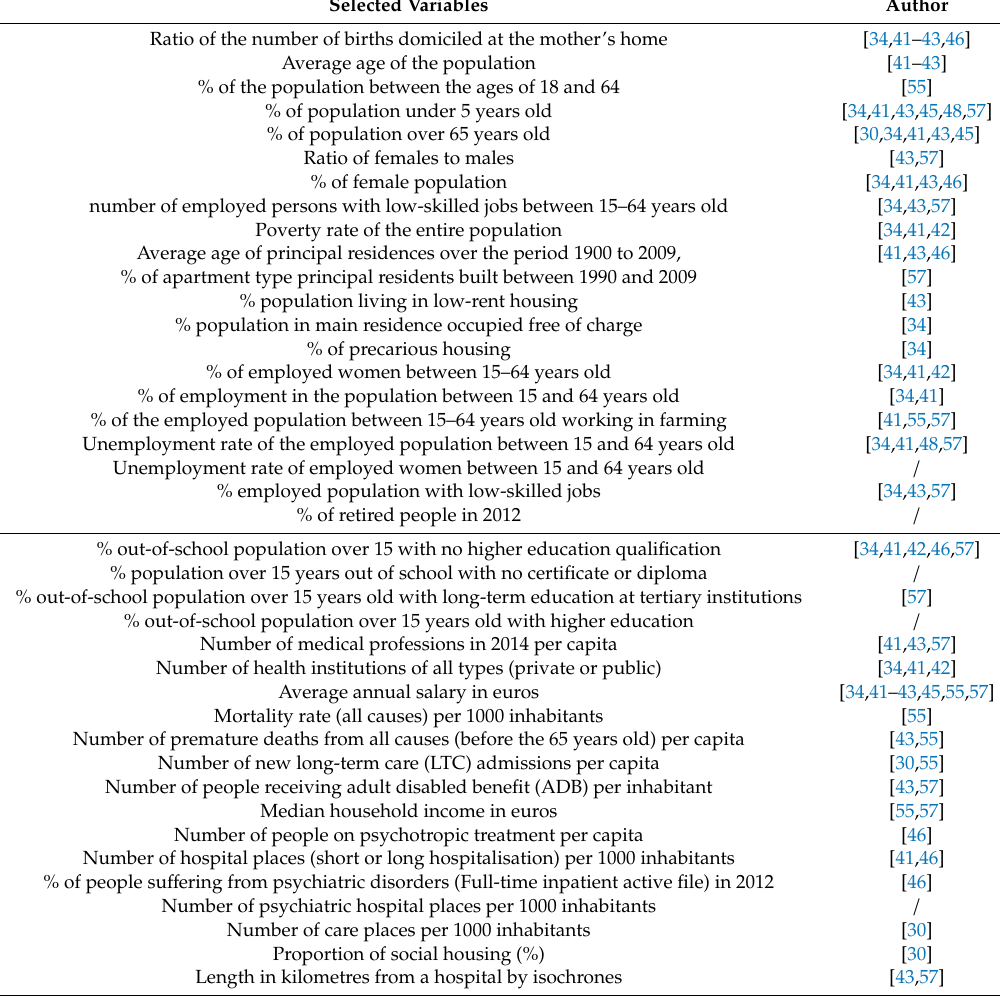
Table 3. Variables selected in the assessment of socio-economic vulnerability to heatwave hazard. Selected